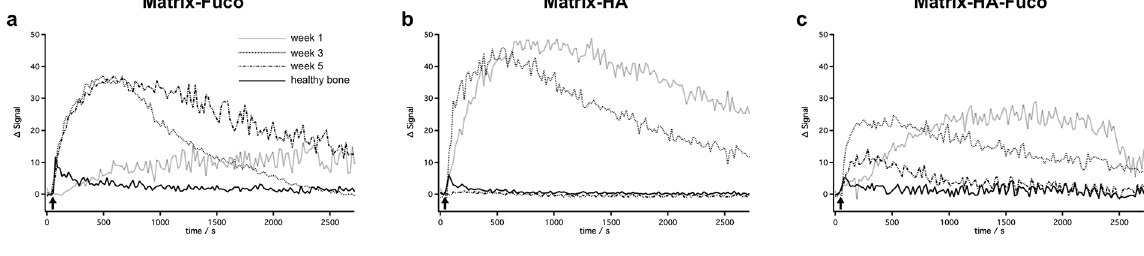
Figure 5. Representative MR Δ Signal (subtracted from the signal measured before injection) over time after the intravenous injection of Gd-DOTA (black arrow) at week 1, 3 and 5 after implantation of Matrix-Fuco ( a ), Matrix-HA ( b ), and Matrix-HA-Fuco ( c ) matrices.